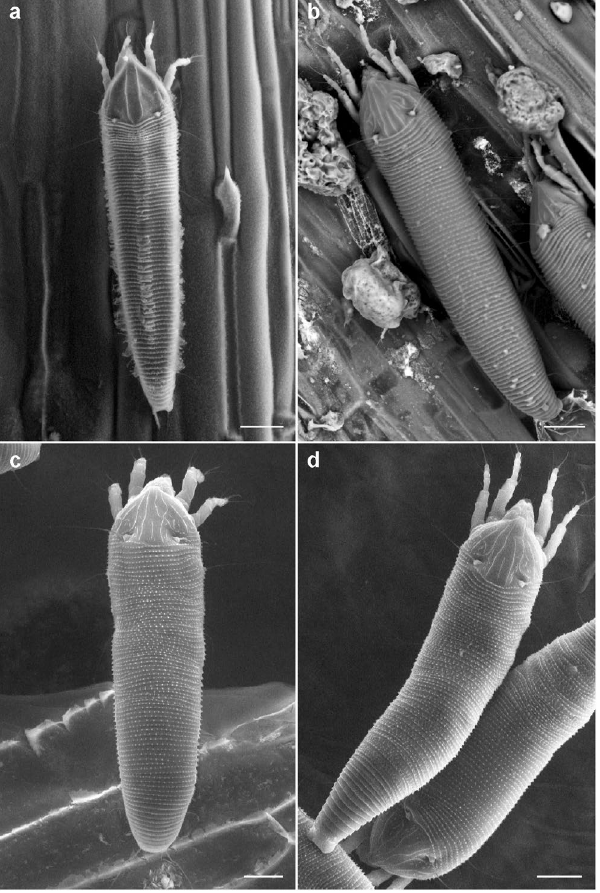
Figure 1. SEM images of eriophyid mites. Scale bars are 10 μ m on each photo. ( a ) – Wheat curl mite ( Aceria tosichella WCM MT-1 genotype) on wheat leaf; ( b ) – Cereal rust mite (CRM, Abacarus hystrix ) on wheat leaf; ( c ) – standing-erect mite belonging to the WCM complex; ( d ) – chain- forming mites belonging to the WCM